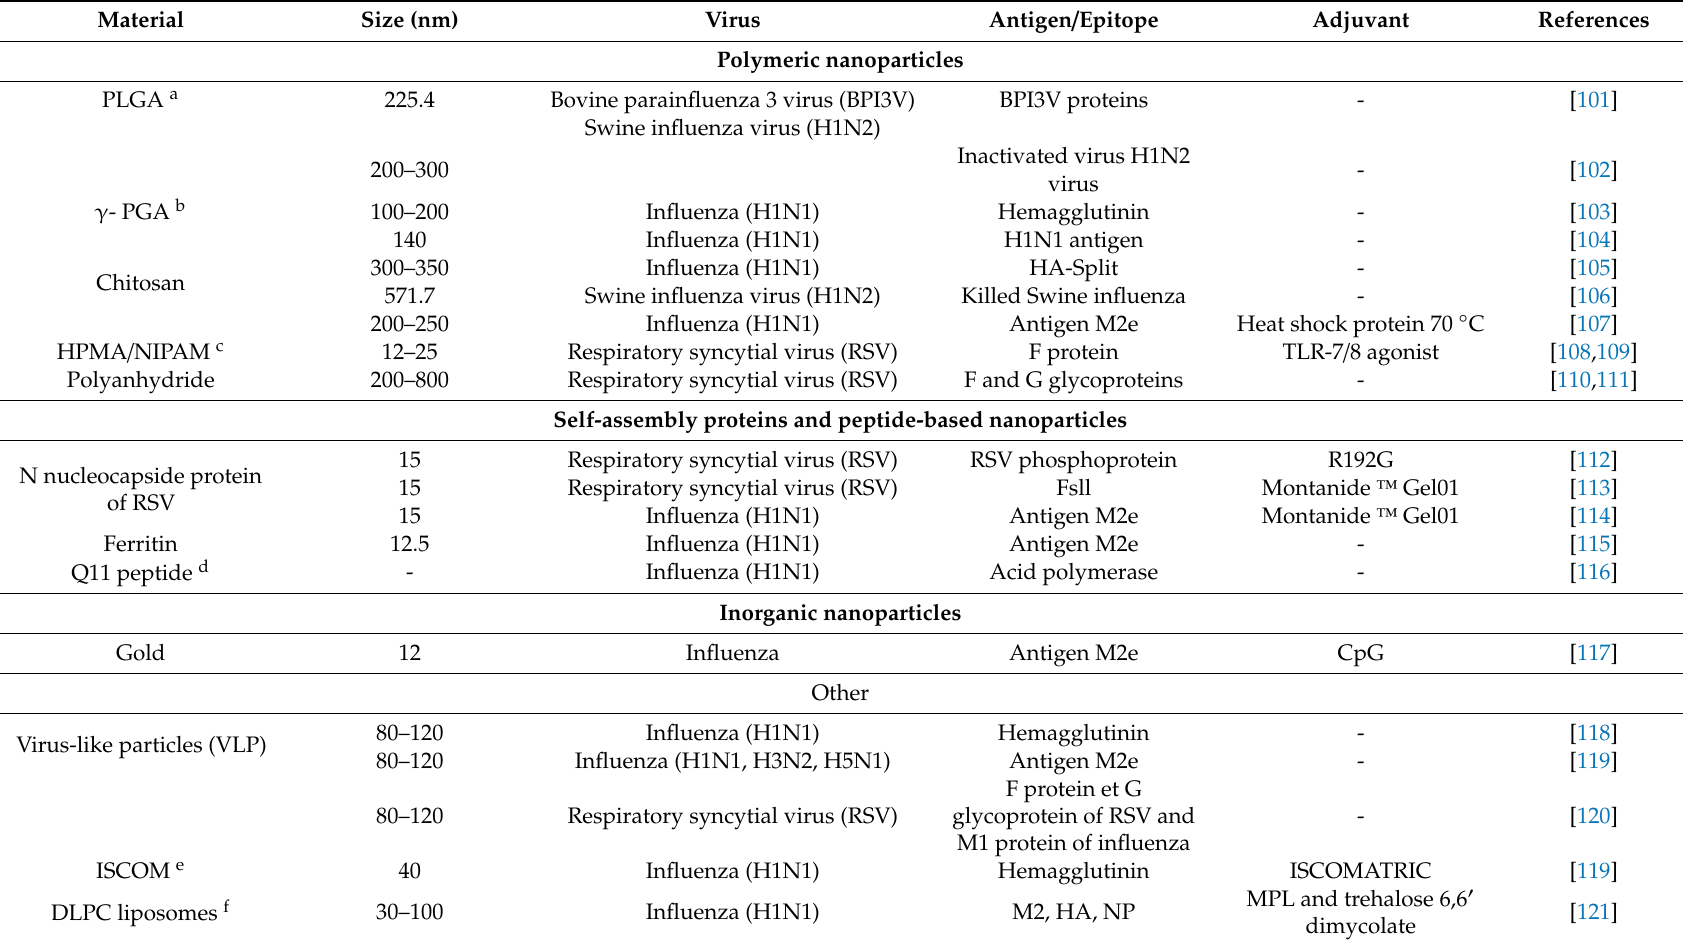
Table 2. Types of nanoparticles against respiratory viruses